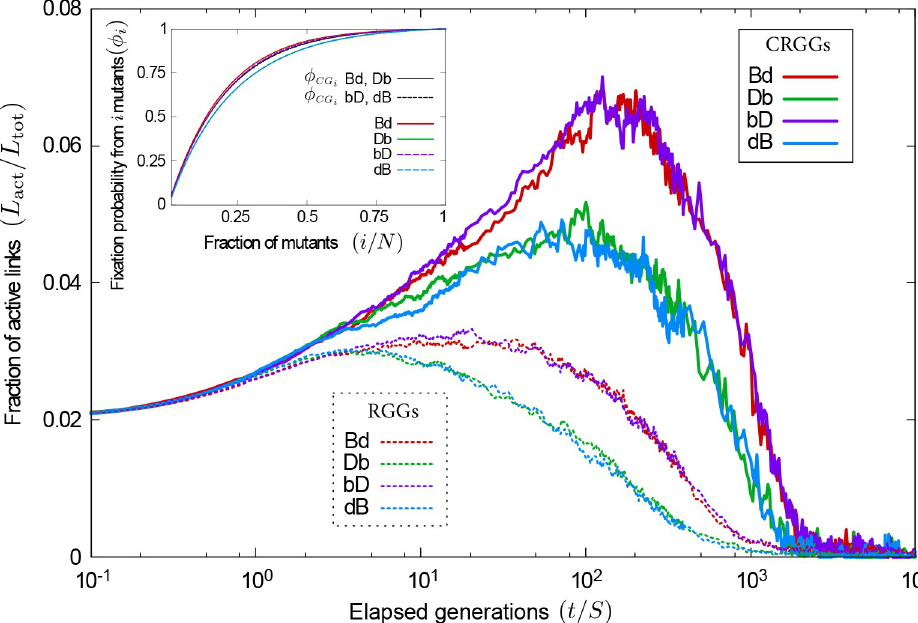
Fig 6. Fragmented initialization promotes the formation of clusters. The main panel shows the average proportion of active links as the evolutionary dynamics proceed. Thick lines correspond to simulations started from connected graphs (CRGGs); thin dotted lines to simulations initialized from unrestricted random positions (RGGs). The fraction of active links is lower for RGGs, regardless of the evolutionary process. Inset : Fixation probability of the mutant species, once there are i mutants in the population. When mutants are a minority, a small increase in their frequency greatly increases their fixation probability. Conversely, reducing their numbers when they are a majority has only minor effects on their chances of success. Simulations in the inset are initialized from